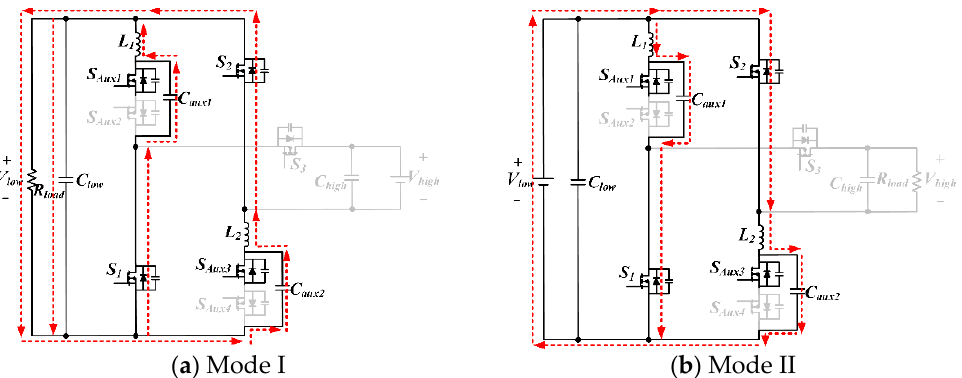
Figure 13. The current flow path of transition from step-down to step-up mode.